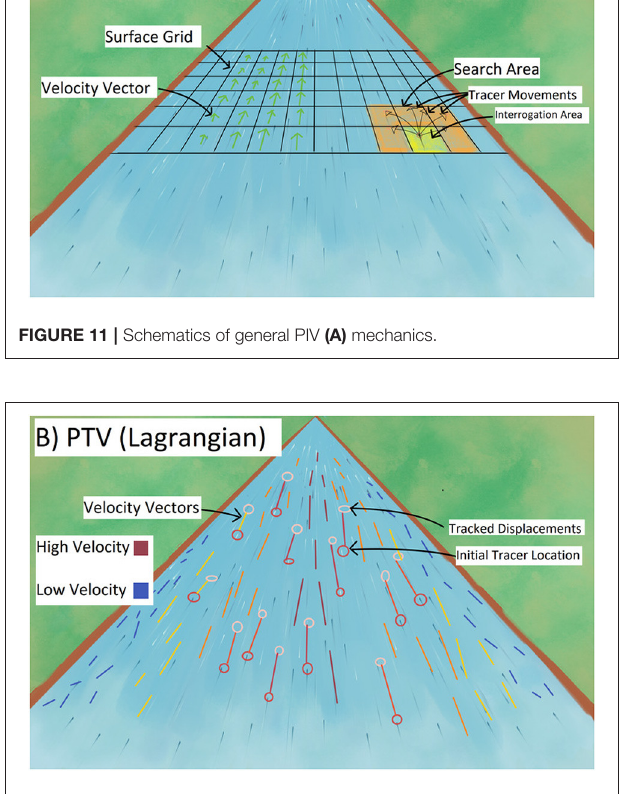
FIGURE 12 | Schematics of general PTV (B)